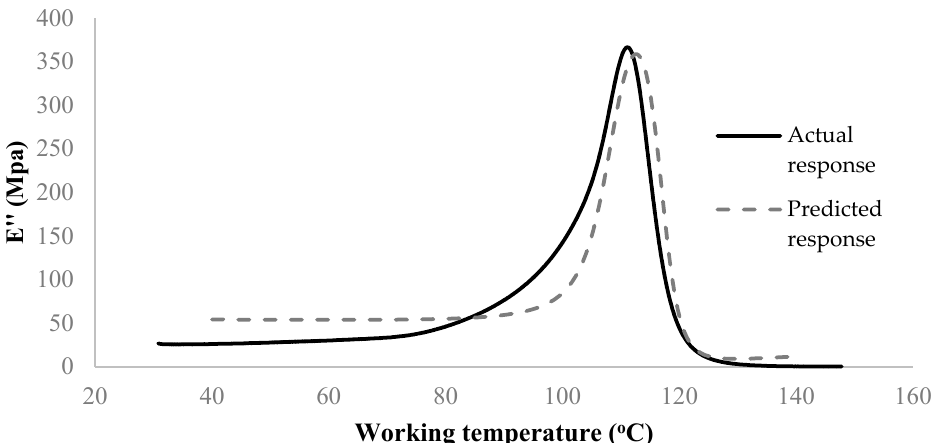
Figure 13. Comparison of the actual and predicted (virtual DMA test of) loss modulus, E ’’, under run #9.